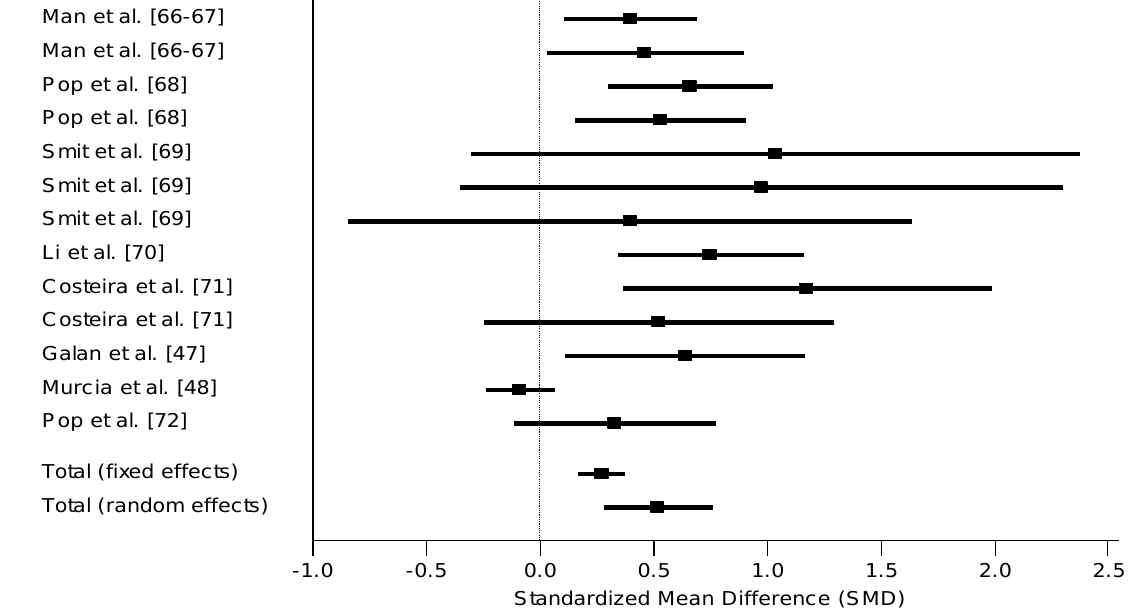
Figure 3. Forest plot for effect size (Standard mean difference SMD and 95% confidence interval) of iodine on mental development of children, cohort prospective studies stratified by maternal iodine status. The studies are heterogeneous ( Q = 34.85, df = 12, p < 0.001). The random effects model was therefore more appropriate. Estimated effect size of 0.1 in Oken’s study not included as details for computation not